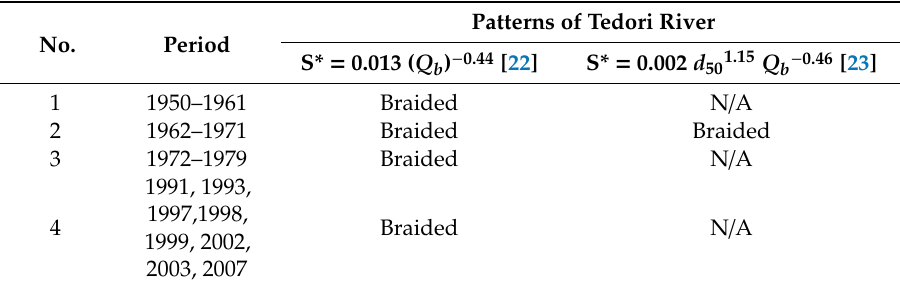
Figure 14. Comparison of aerial photographs of LTR over two dates. Table 1. Patterns of the Tedori River for several periods.